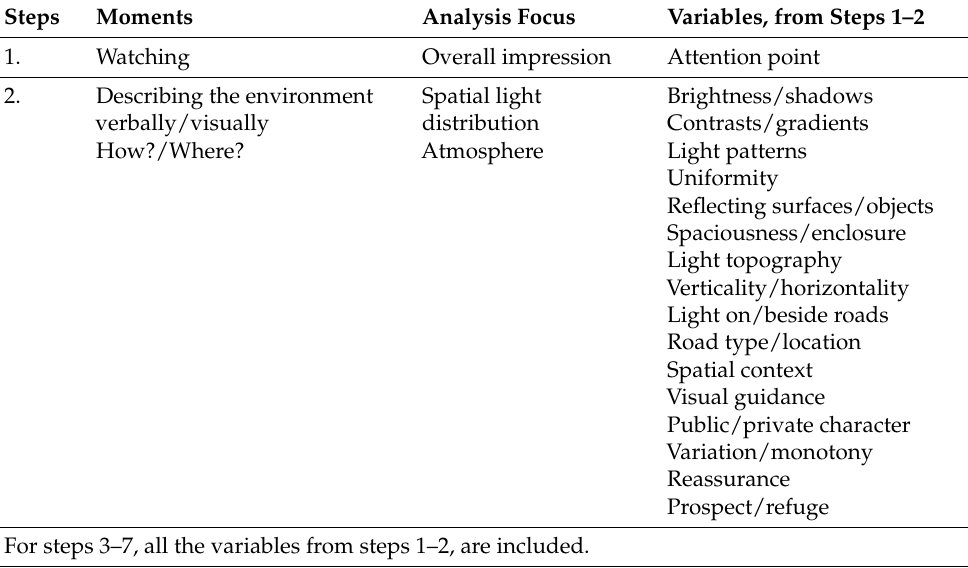
Table 1. Phases in the visual observation and the analysis